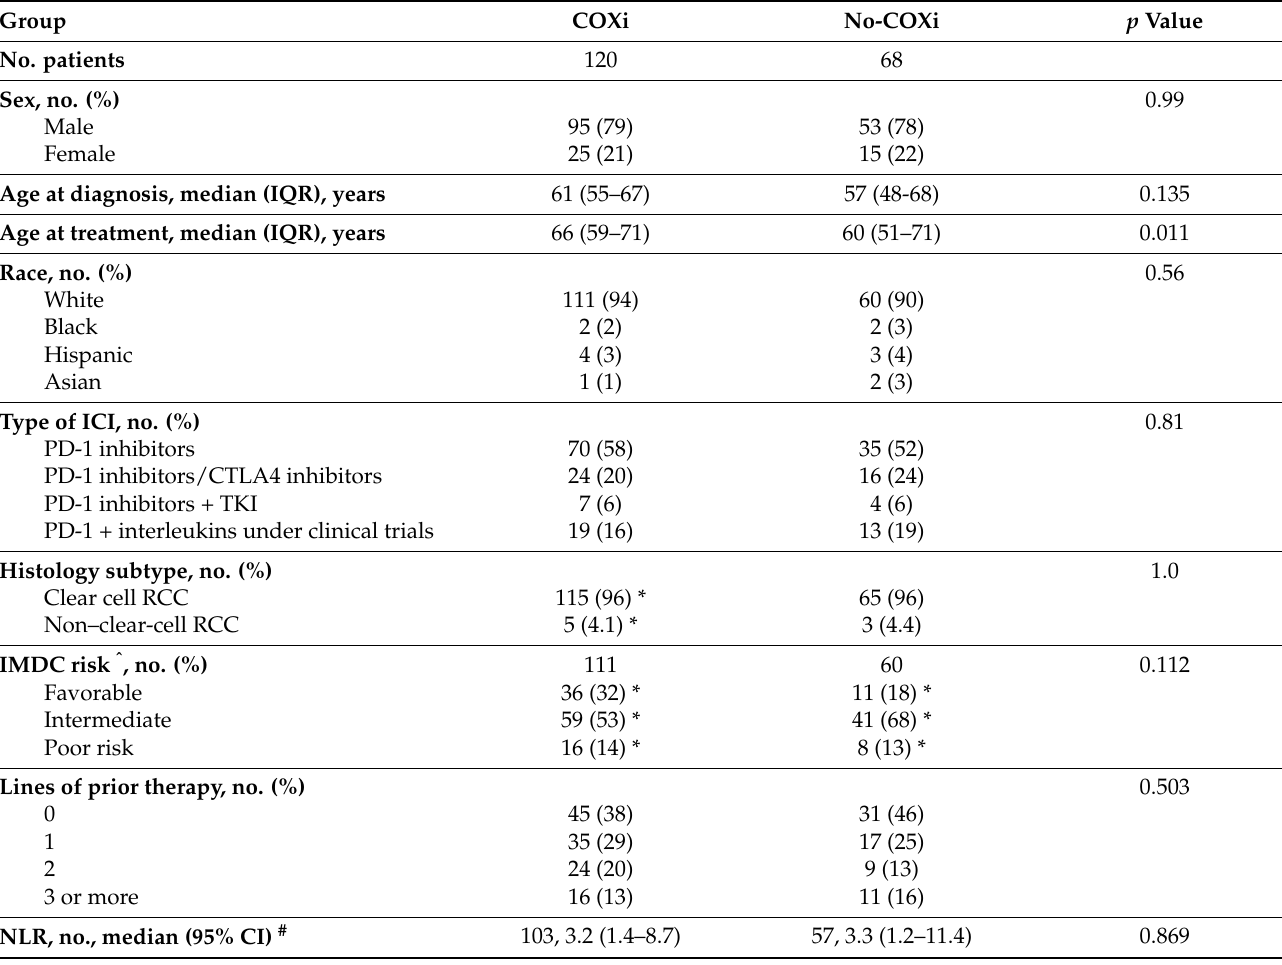
Table 1. Characteristics of 188 Patients who Received Immune Checkpoint Inhibitors for Metastatic Renal Cell